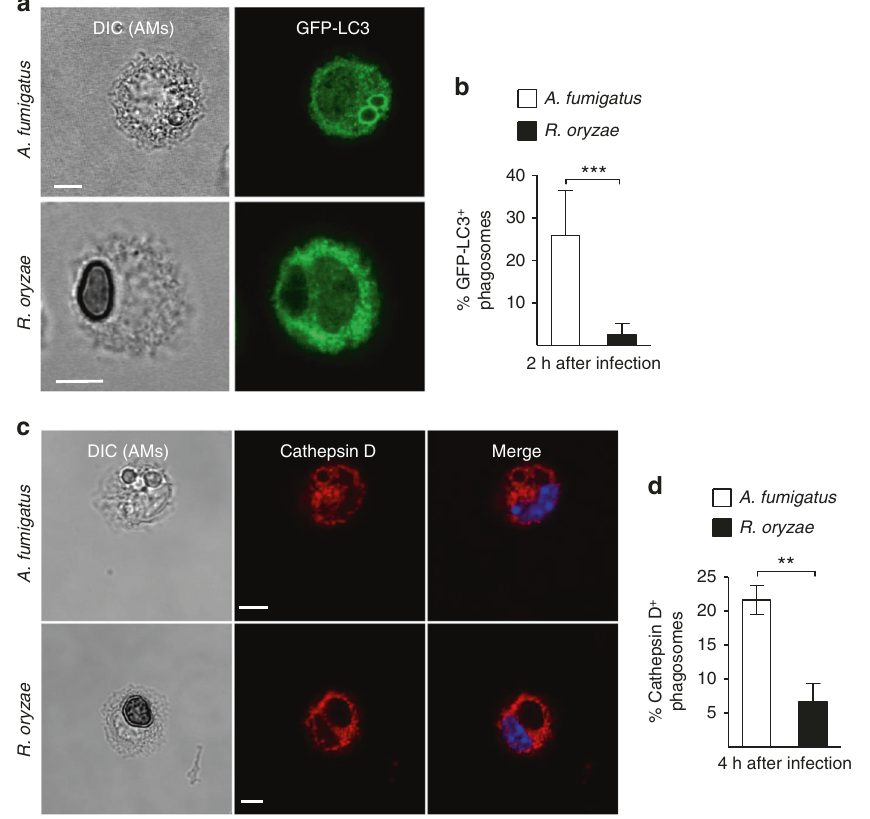
Fig. 4 Rhizopus inhibits phagosome biogenesis in AMs during in vivo infection. GFP-LC3 ( a , b ) or C57BL/6 (B6) ( c , d ) mice were infected intratracheally with 5 × 10 6 conidia of either R. oryzae or A. fumigatus . AMs were obtained by bronchoalveolar lavage at the indicated time point, fi xed, stained with anti- GFP ( a ) or Cathepsin D ( b ) antibodies, and assessed by confocal imaging. Representative fl uorescence images are shown ( a , c ). Data on quanti fi cation of GFP-LC3 + ( b ) and Cathepsin D + ( d ) phagosomes are presented as mean ± SEM of three independent experiments. *** P < 0.0001, ** P < 0.001 Mann – Whitney test. Scale bar, 5 μ